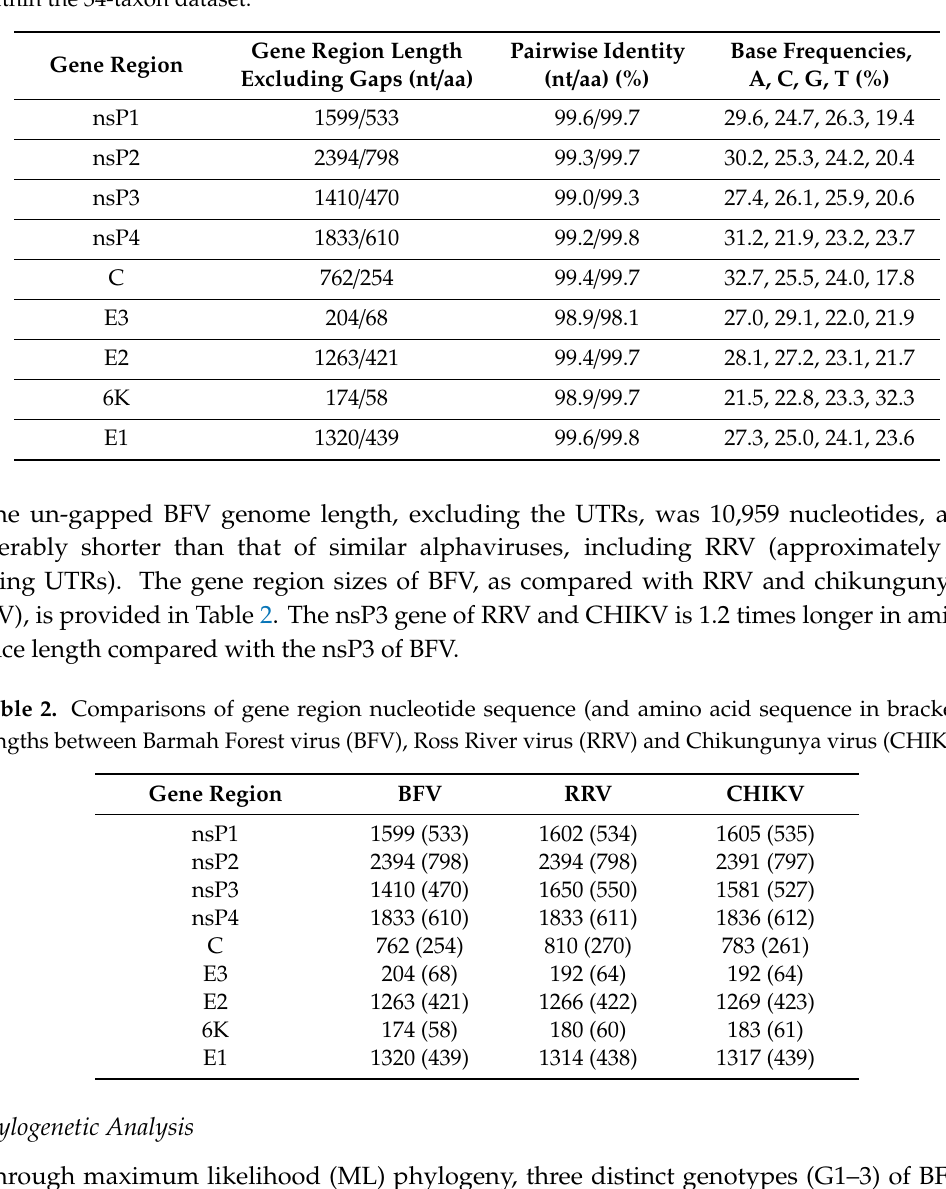
Table 1. The nucleotide (nt) and amino acid (aa) sequence length (excluding gaps), the average pairwise nt and aa identity (%) and the base frequency of each individual Barmah Forest virus gene region within the 34-taxon dataset.